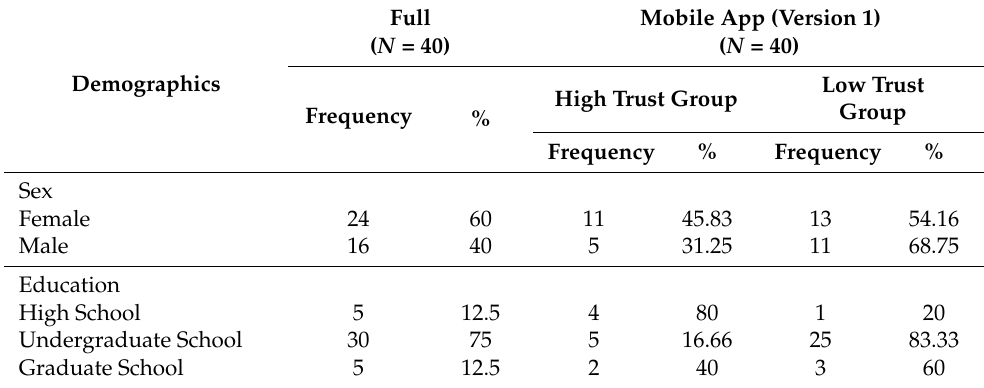
Figure 7. User Trust Evaluation for the Mobile application Version 2. Table 11. Demographic Results for Trust Evaluation of the Mobile Application Version